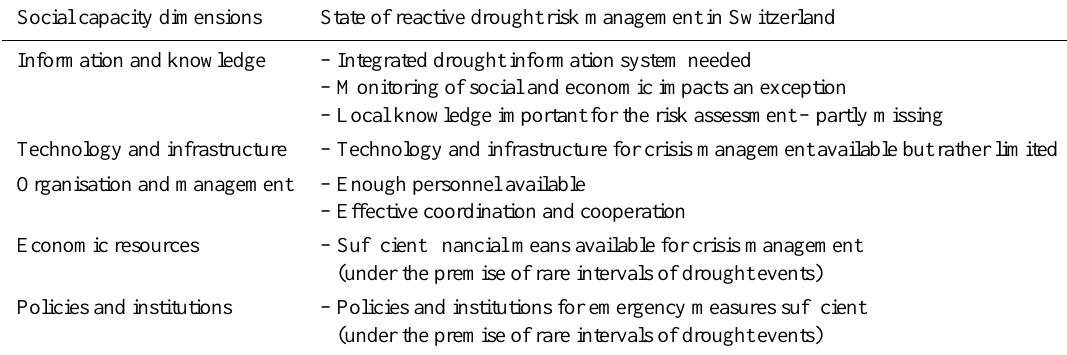
Table 6. State of social capacities for reactive drought risk management in